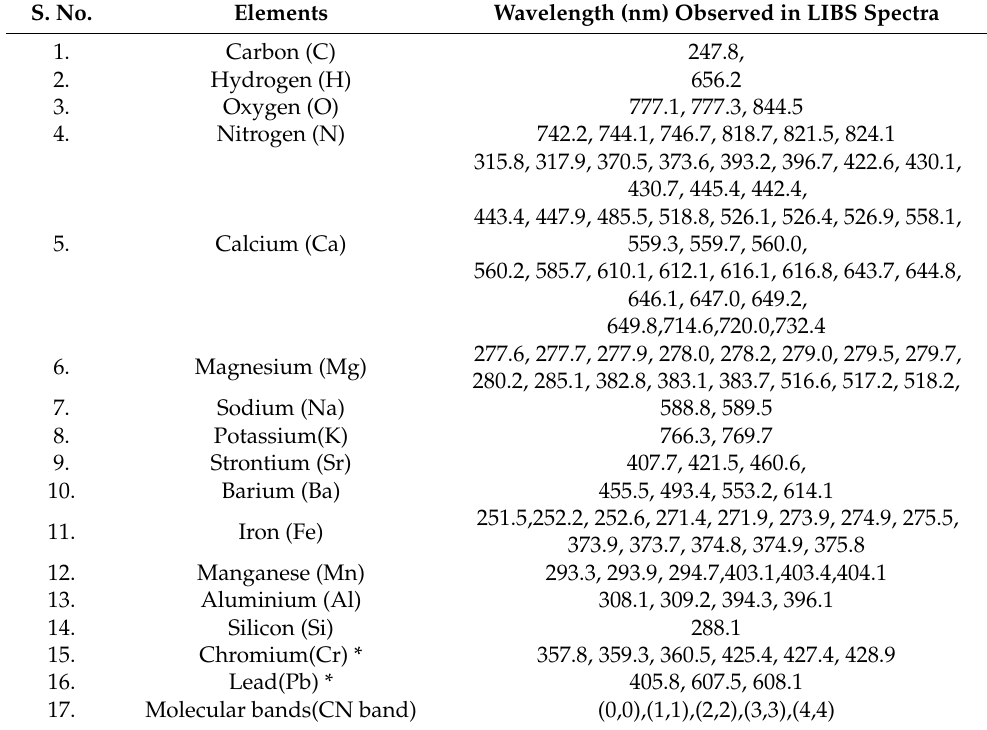
Table 1. Details of the identified elements and molecular band present in